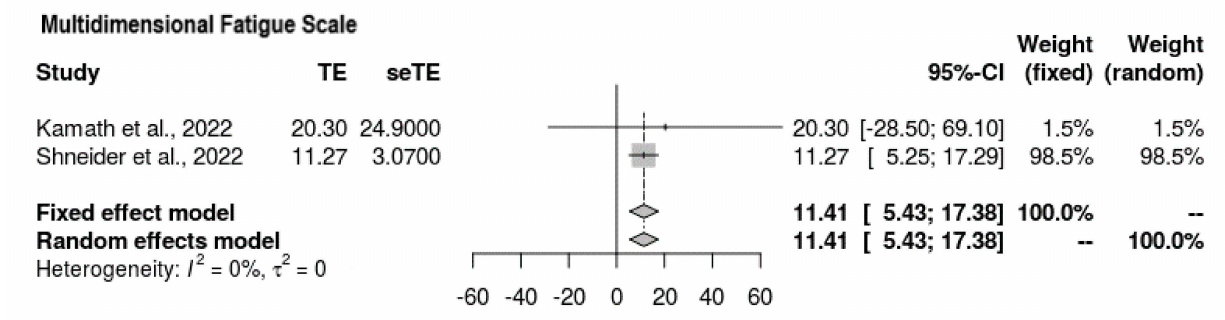
Figure 4. Forest plot depicting Multidimensional Fatigue Scale outcomes [21,22].